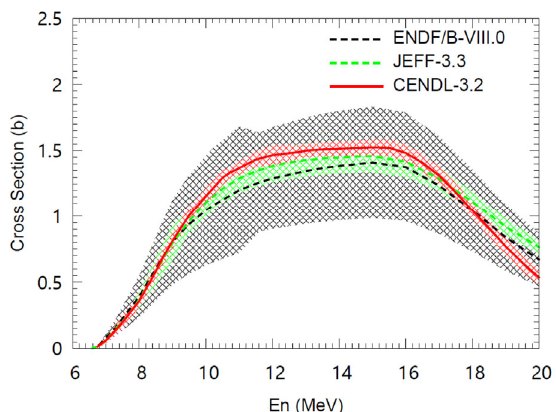
Fig. 5. The evaluated uncertainties relevant to the cross sections in Fig. 4.